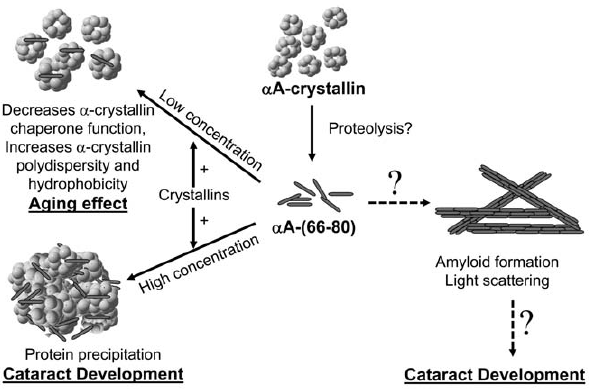
Figure 8. Schematic of a A-(66-80) peptide–mediated lens aging and cataract development. In vivo a A-(66-80) peptides interact with crystallins and affect the structure and organization of crystallins, leading to age-related changes and cataract development. At low concentrations, a A-(66-80) specifically interacts with a -crystallin, result- ing in increased hydrophobicity and polydispersity and decreased chaperone activity of a -crystallin. At higher concentrations, a A-(66-80) binds to crystallins, leading to insolubilization of crystallins and cataract development. Localized accumulation of the a A-(66-80) peptide has the potential to form light-scattering amyloid-like structures. However, the latter is less likely because the interaction of the peptide with crystallins suppresses the formation of